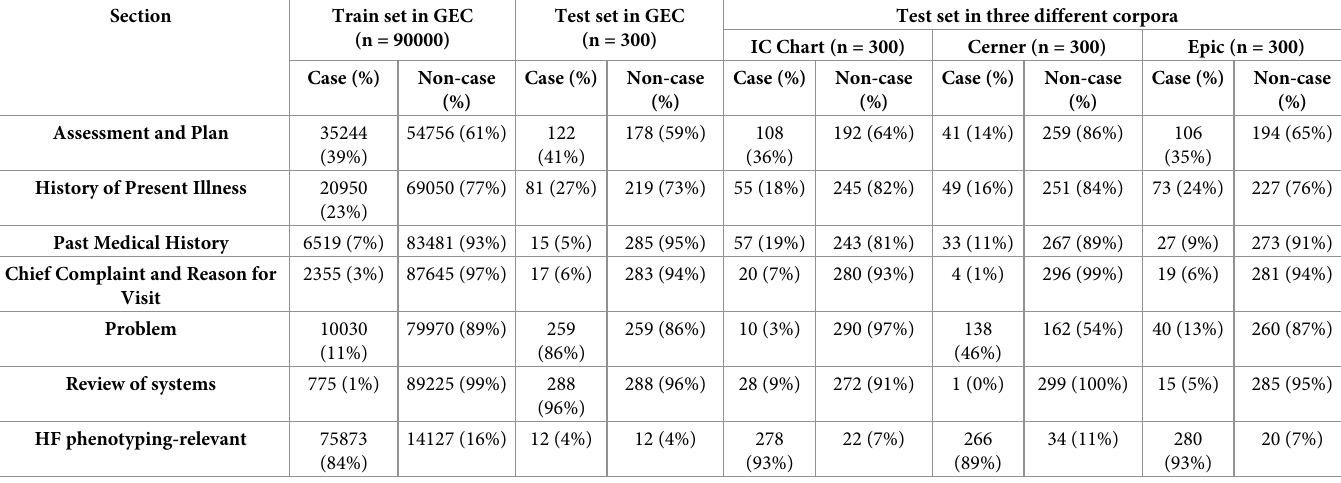
Table 2. Case a and non-case b for train set in GEC and the heart failure relevant clinical section in test sets.